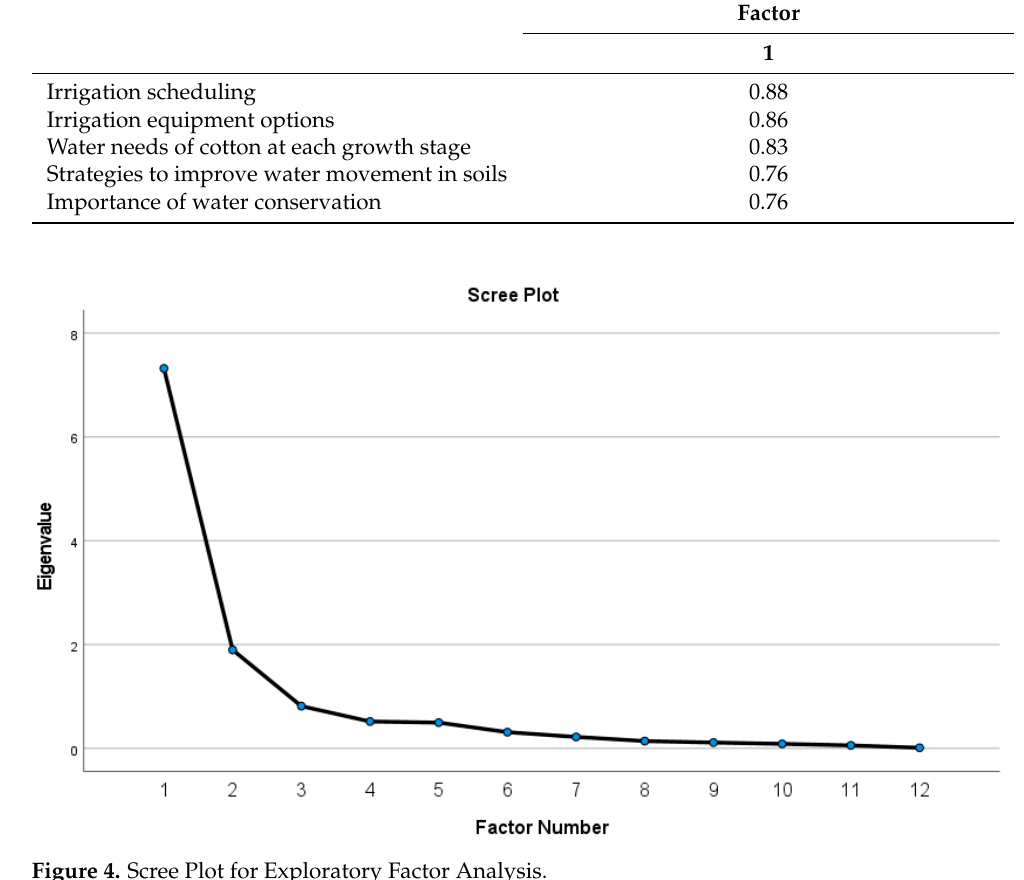
The importance of integrated pest management competencies was analyzed using a